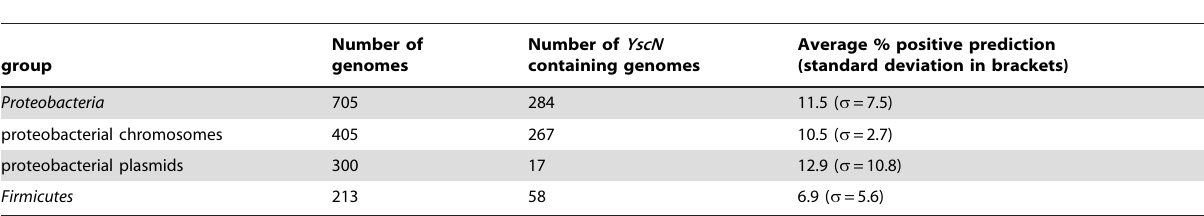
Table 2. Prediction results for the genomes ( in silico translated sequences) of Proteobacteria and Firmicutes .